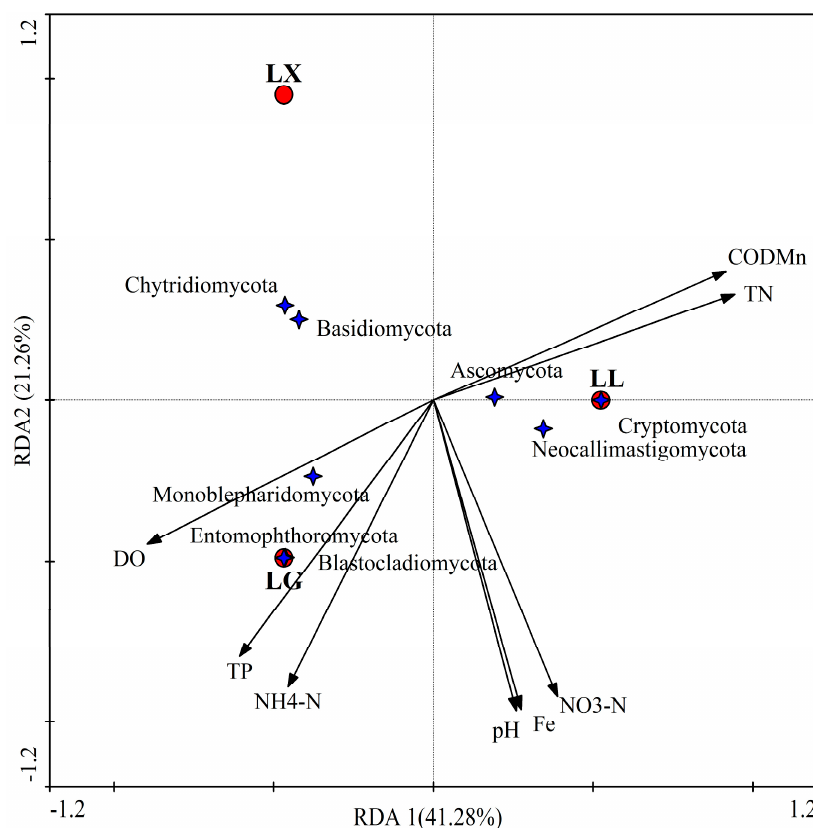
Figure 8. Redundancy analysis (RDA) of water fungal communities in LX, LG and LL. RDA1 explained 41.28%, and RDA2 explained 21.26% of the total variance. LX, LG and LL represent Xingqing lake, Geming lake and Lianhu lake, respectively. Water quality was found to be significantly correlated with fungal community structure.